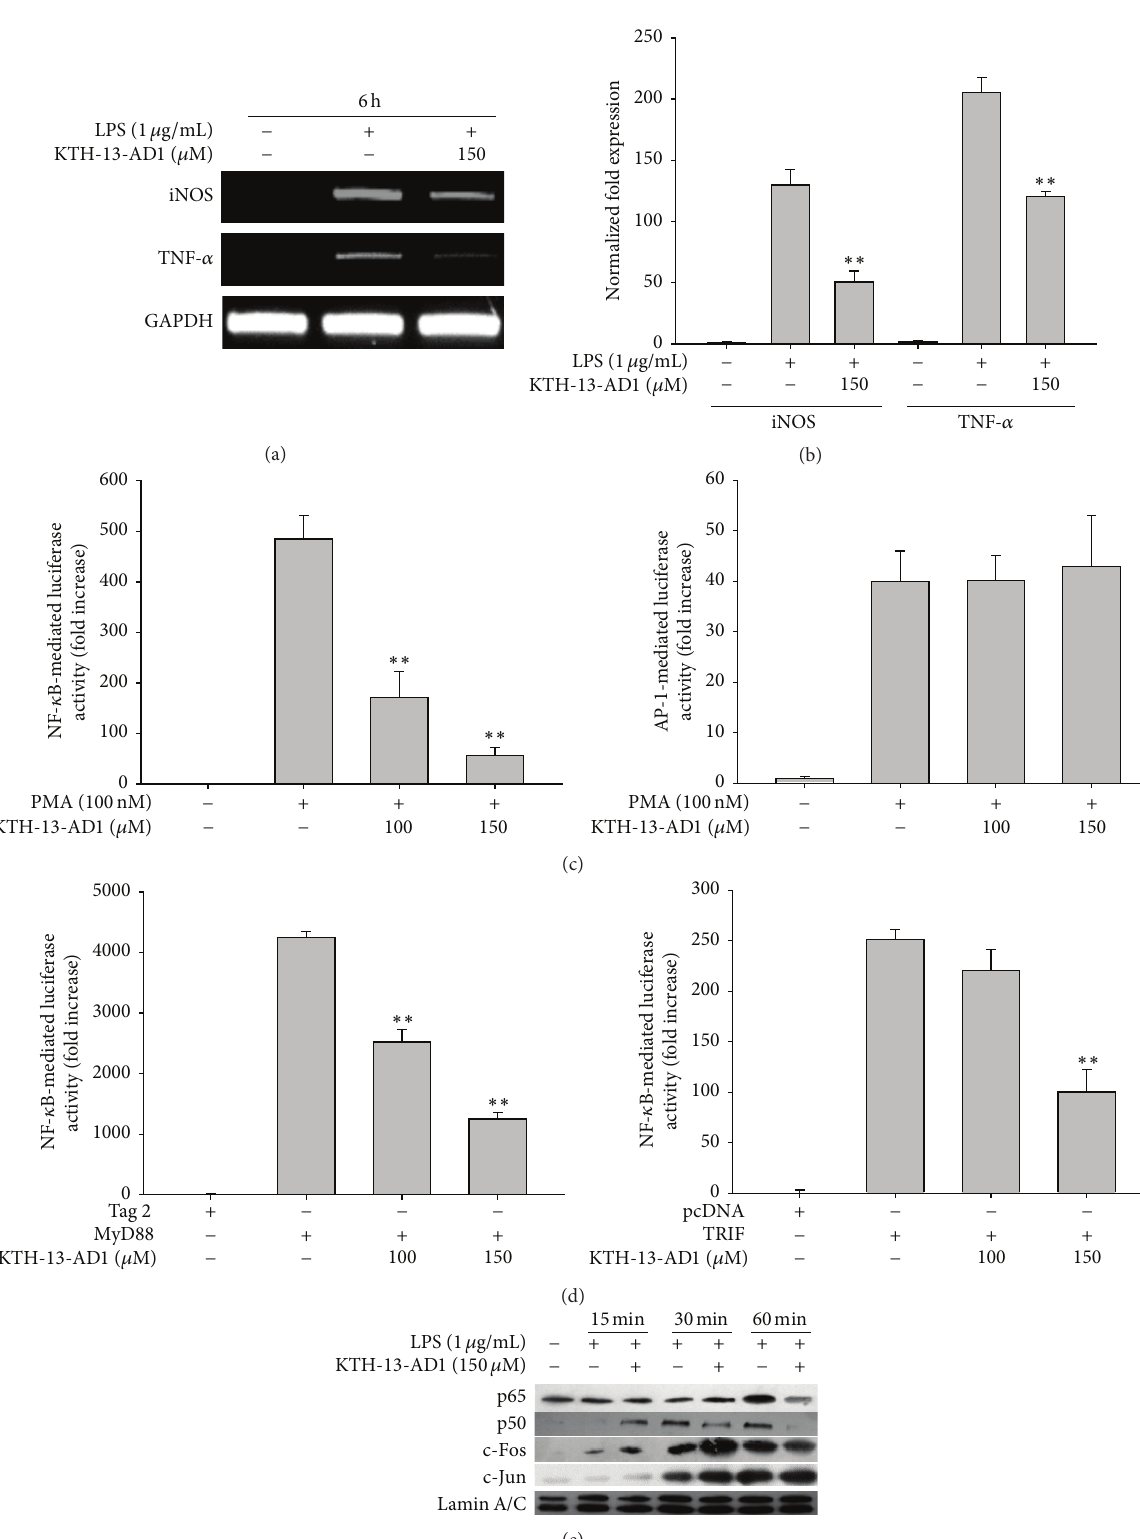
Figure 2: Effects of KTH-13-AD1 on transcriptional activation of LPS-mediated inflammatory responses. (a, b) mRNA levels of proinflammatory genes (iNOS and TNF- 𝛼 ) in LPS-treated RAW264.7 cells pretreated with KTH-13-AD1 (150 𝜇 M), as analyzed by RT-PCR (a) and real-time PCR (b). (c, d) Transcriptional activation of inflammatory responses was examined using a luciferase reporter gene assay with HEK293 cells transfected with NF- 𝜅 B-Luc or AP-1-Luc, as well as with 𝛽 -gal (as a transfection control) under either treatment with PMA or cotransfection with FLAG-MyD88 or CFP-TRIF (1 𝜇 g/mL each). Luciferase activity was measured using a luminometer. (e) The nuclear translocation levels of AP-1 (c-Jun and c-Fos) and the NF- 𝜅 B (p65 and p50) family in LPS-treated RAW264.7 cells (5 × 10 6 cells/mL) pretreated with KTH-13-AD1, as examined using nuclear fractionation and immunoblotting analysis. ∗∗ 𝑃 < 0.01 compared to the vehicle